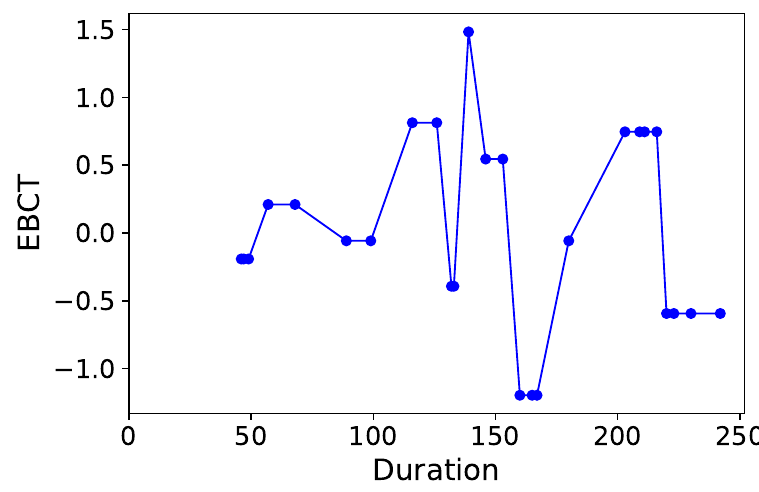
Figure A7. Normalized empty-bed contact time for Reactor 1.